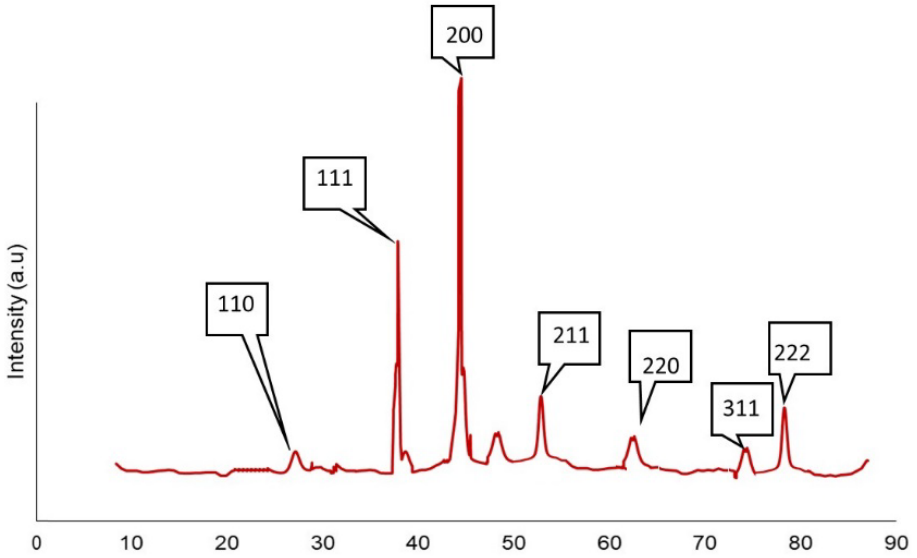
Figure 8. XRD patterns of cuprous oxide particles.